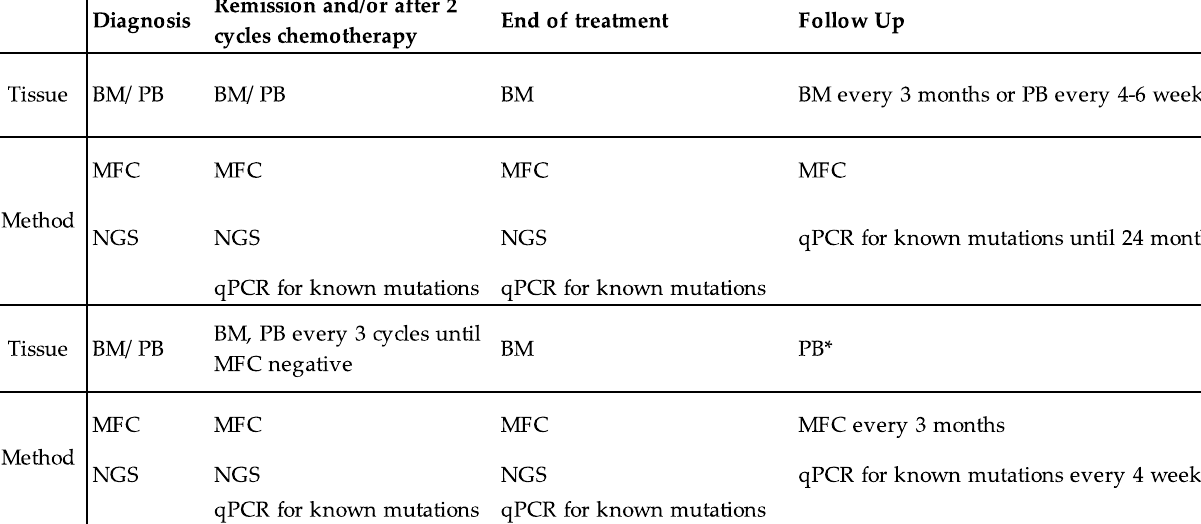
Figure 1. MRD Monitoring in AML. Recommendations adapted from the 2021 European Leuke- miaNet Guidelines [10], the National Comprehensive Cancer Network AML Guidelines version 1.2022 [11], and our clinical experience and emerging data on lower intensity regimens [38]. Tissues for MRD testing include peripheral blood (PB) and bone marrow (BM). MRD quantification tech- niques include multiparameter flow cytometry (MFC), next-generation sequencing (NGS), and quantitative polymerase chain reaction (qPCR). * Bone marrow studies can be obtained as clinically indicated in patients on continuation/maintenance therapy or after treatment